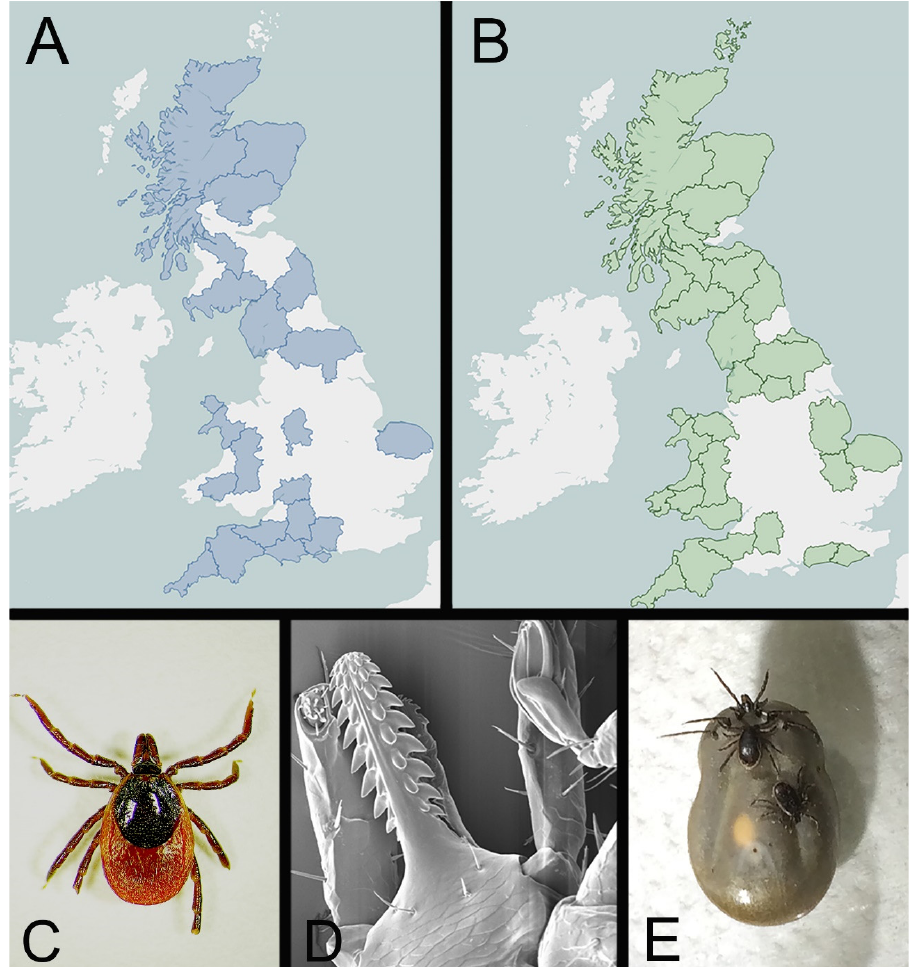
Figure 1. Ixodes ricinus and tick-borne disease within Great Britain. ( A ) Map of the British Isles showing the distribution (in blue) of cases of tick-borne disease in cattle (tick-borne fever, babesiosis and louping ill) reported by APHA between 2012 and 2021. ( B ) Map of the British Isles showing the distribution (in green) of cases of tick-borne disease in sheep (tick-borne fever, louping ill and tick pyaemia) reported by APHA between 2012 and 2021. ( C ) Image of adult female Ixodes ricinus (photo Arran Folly). ( D ) Scanning electron micrograph of the mouth parts of an Ixodes ricinus larva (photo Bill Cooley). ( E ) Image of an engorged female Ixodes ricinus with males (photo Nicholas Johnson). Maps generated by APHA’s Surveillance Intelligence Unit accessible at APHA Vet Gateway: Livestock disease surveillance dashboards (defra.gov.uk, accessed on 18 April 2022) using software under licence from https://public.tableau.com (accessed on 18 April 2022).